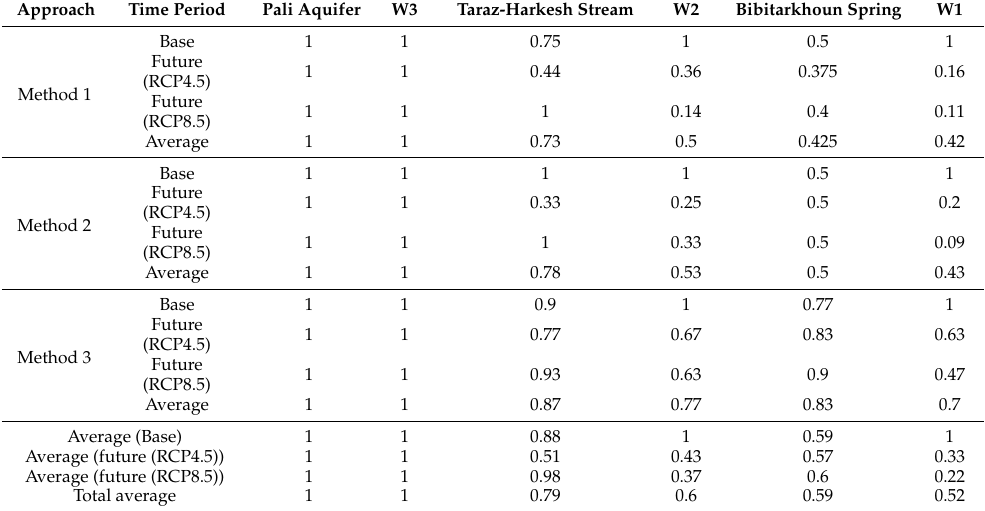
Table 5. The GRI and SWRI of various water resources in the Lali region in the base and future time periods under RCP4.5 and RCP8.5, considering different